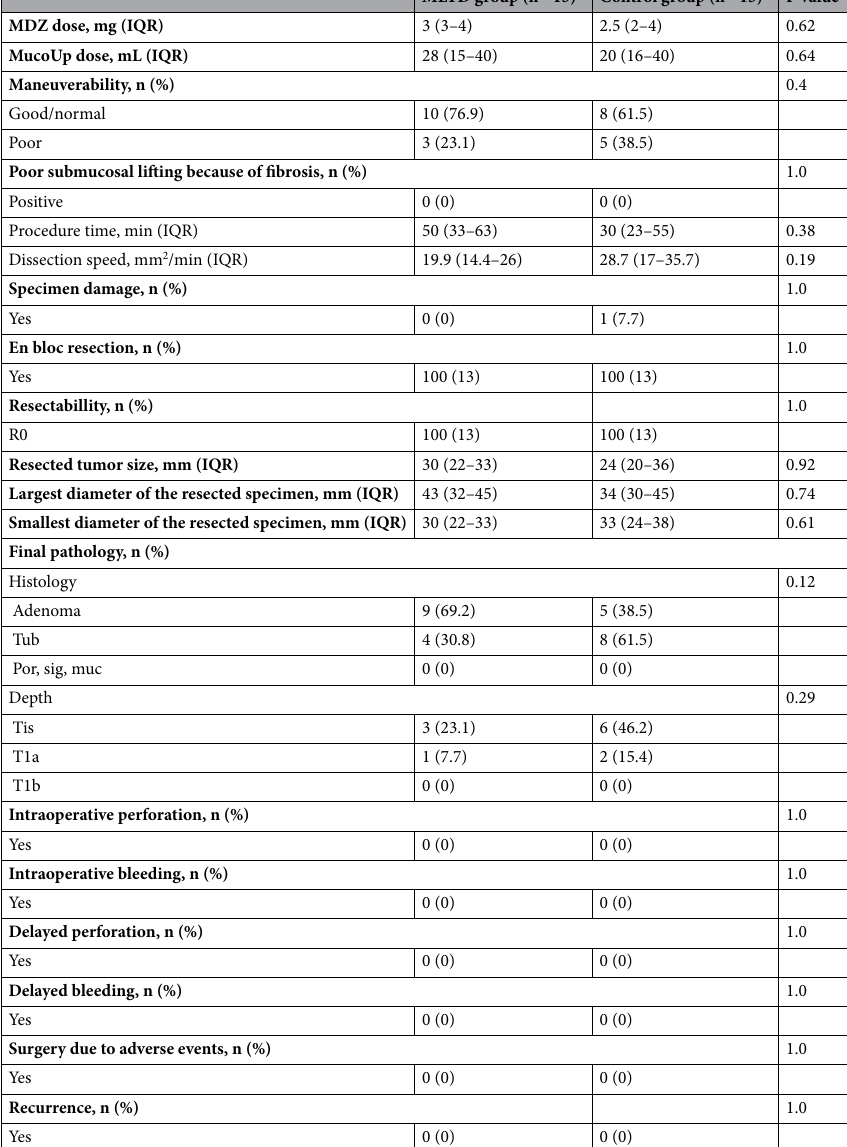
Table 2. Treatment outcomes. IQR interquartile range, MZD midazolam.